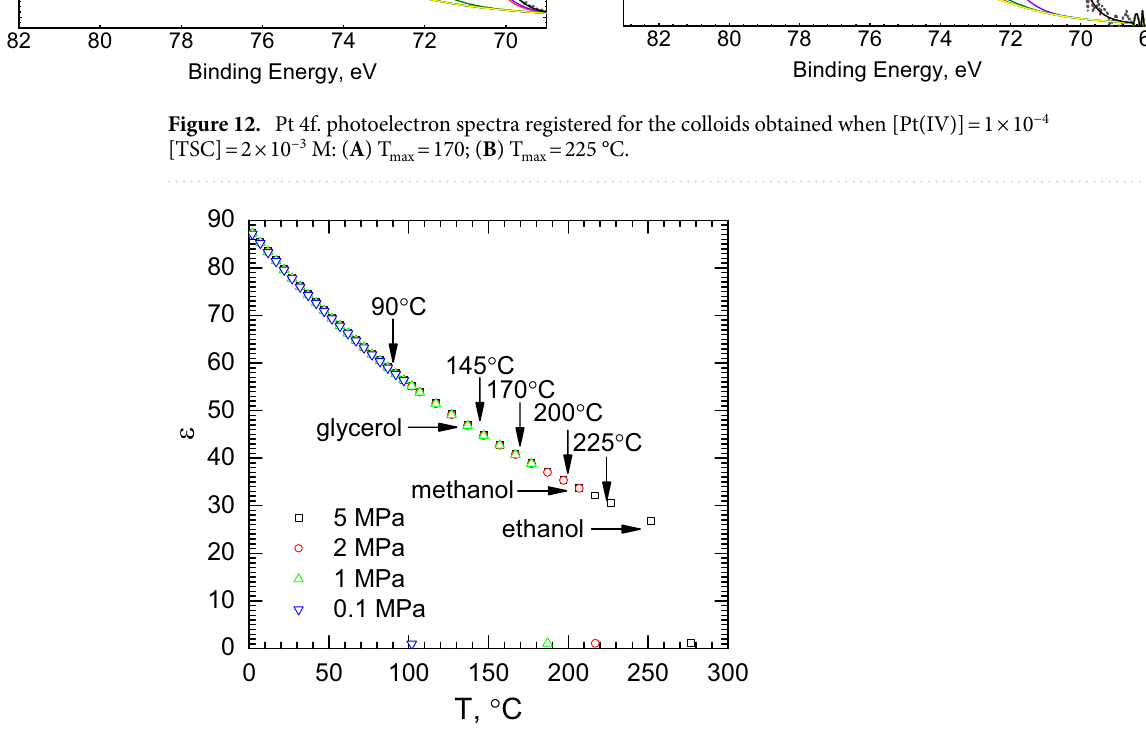
Figure 13. Dielectric permittivity of water as a function of temperature and pressure, data from 43 ; vertical arrows indicate maximal temperatures during synthesis, horizontal ones show dielectric constant of selected organic solvents at room temperature 44